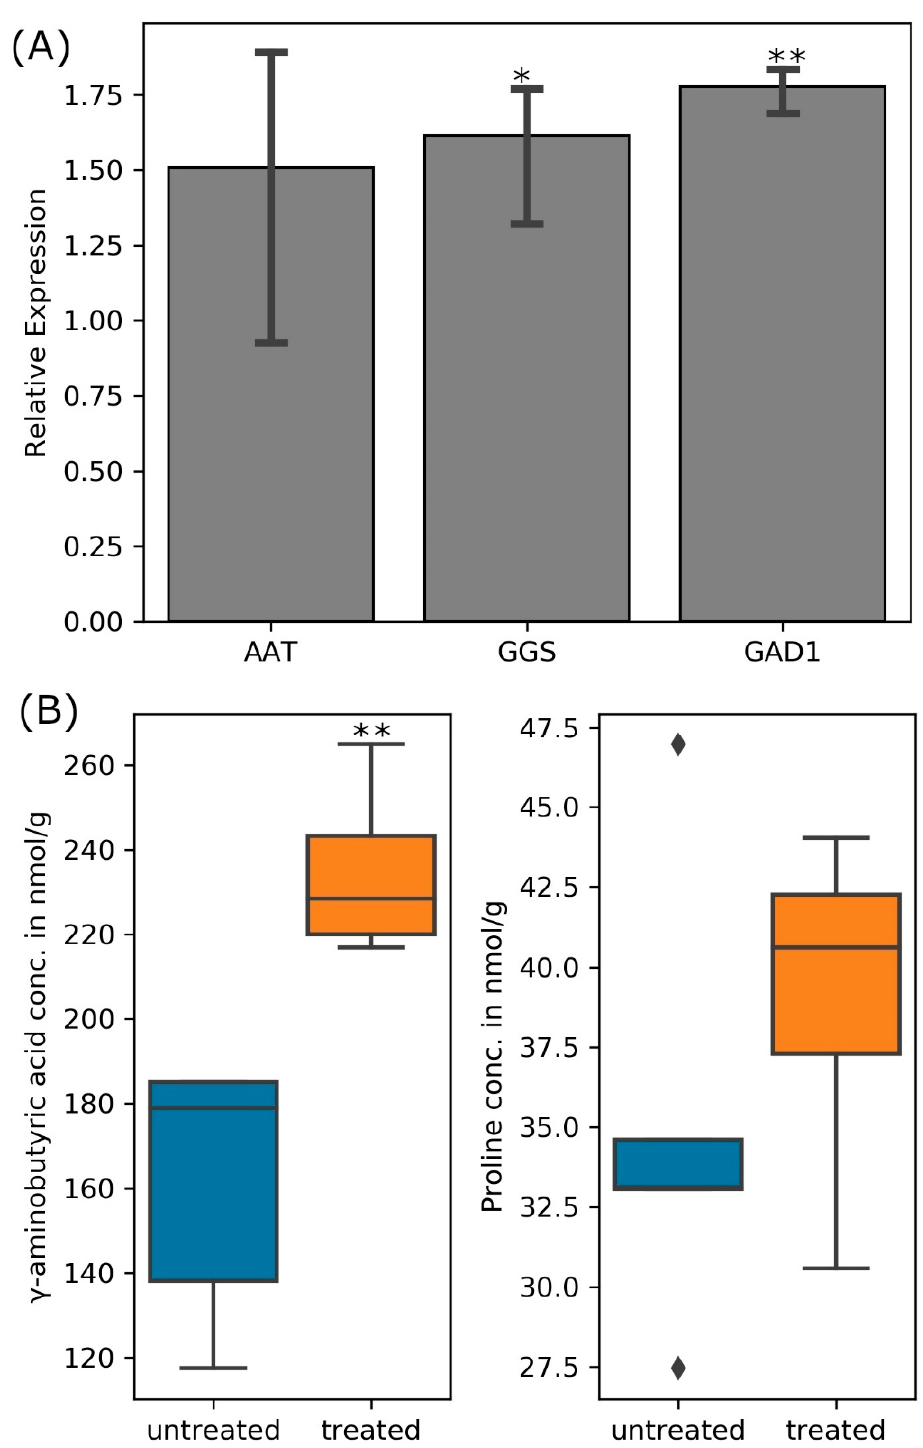
Figure 7. ( A ) Transcript abundance for nodule bacteroids’ aspartate aminotransferase (AAT), glutathione synthase (GGS), and glutamate decarboxylase (GAD1) when infected plants were treated 300 mM NaCl relative to untreated nodules and ( B ) quantity of GABA and proline in the nodules of treated and untreated (control) plants. (one-way ANOVA; * indicates p ≤ 0.05 while ** indicates p ≤ 0.001).